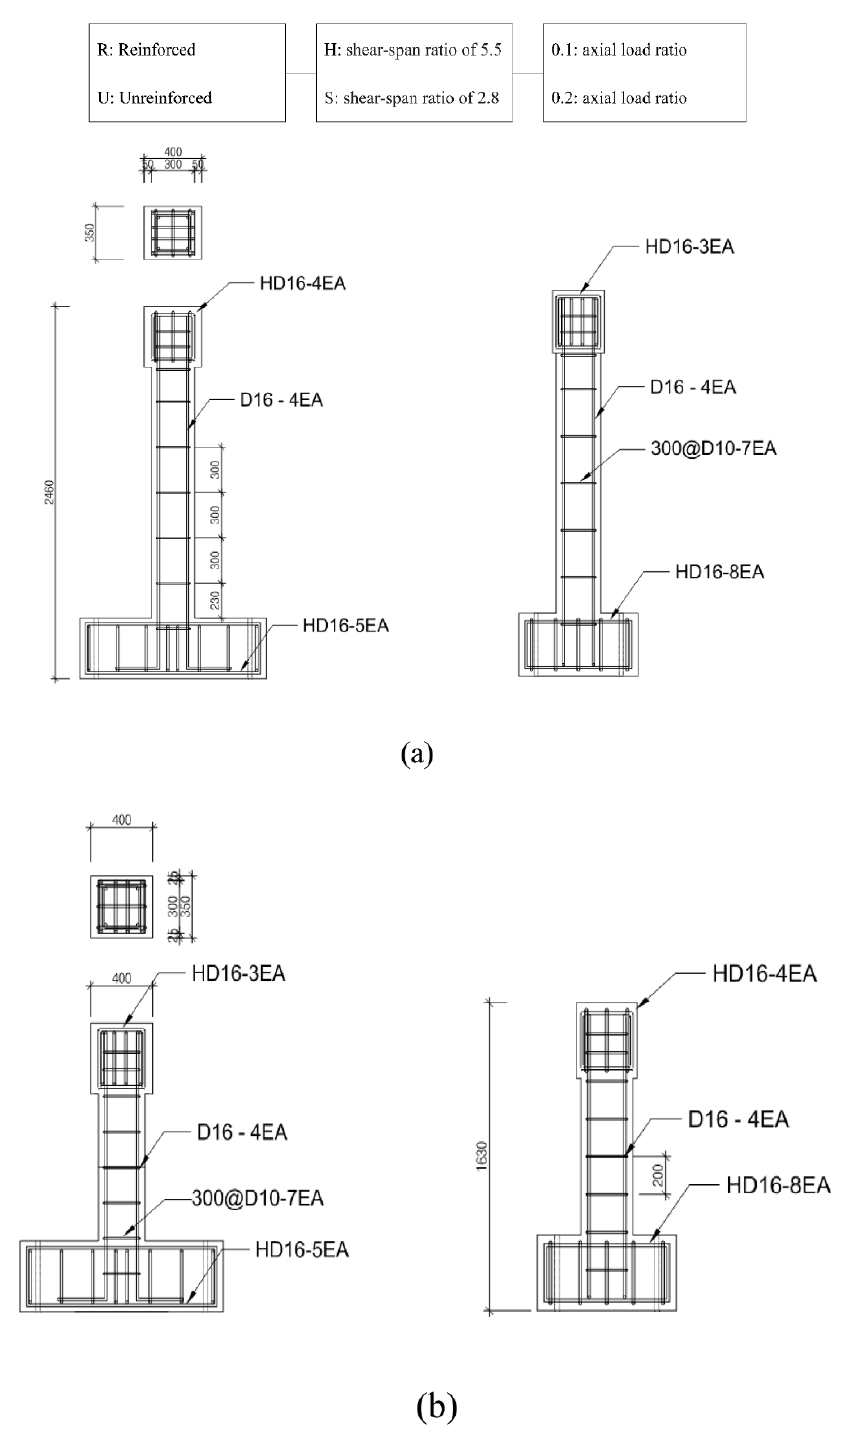
Figure 1. Reinforcement placement of ( a ) H-series and ( b ) S-series (unit: mm). 300@ means 300 mm spacing.